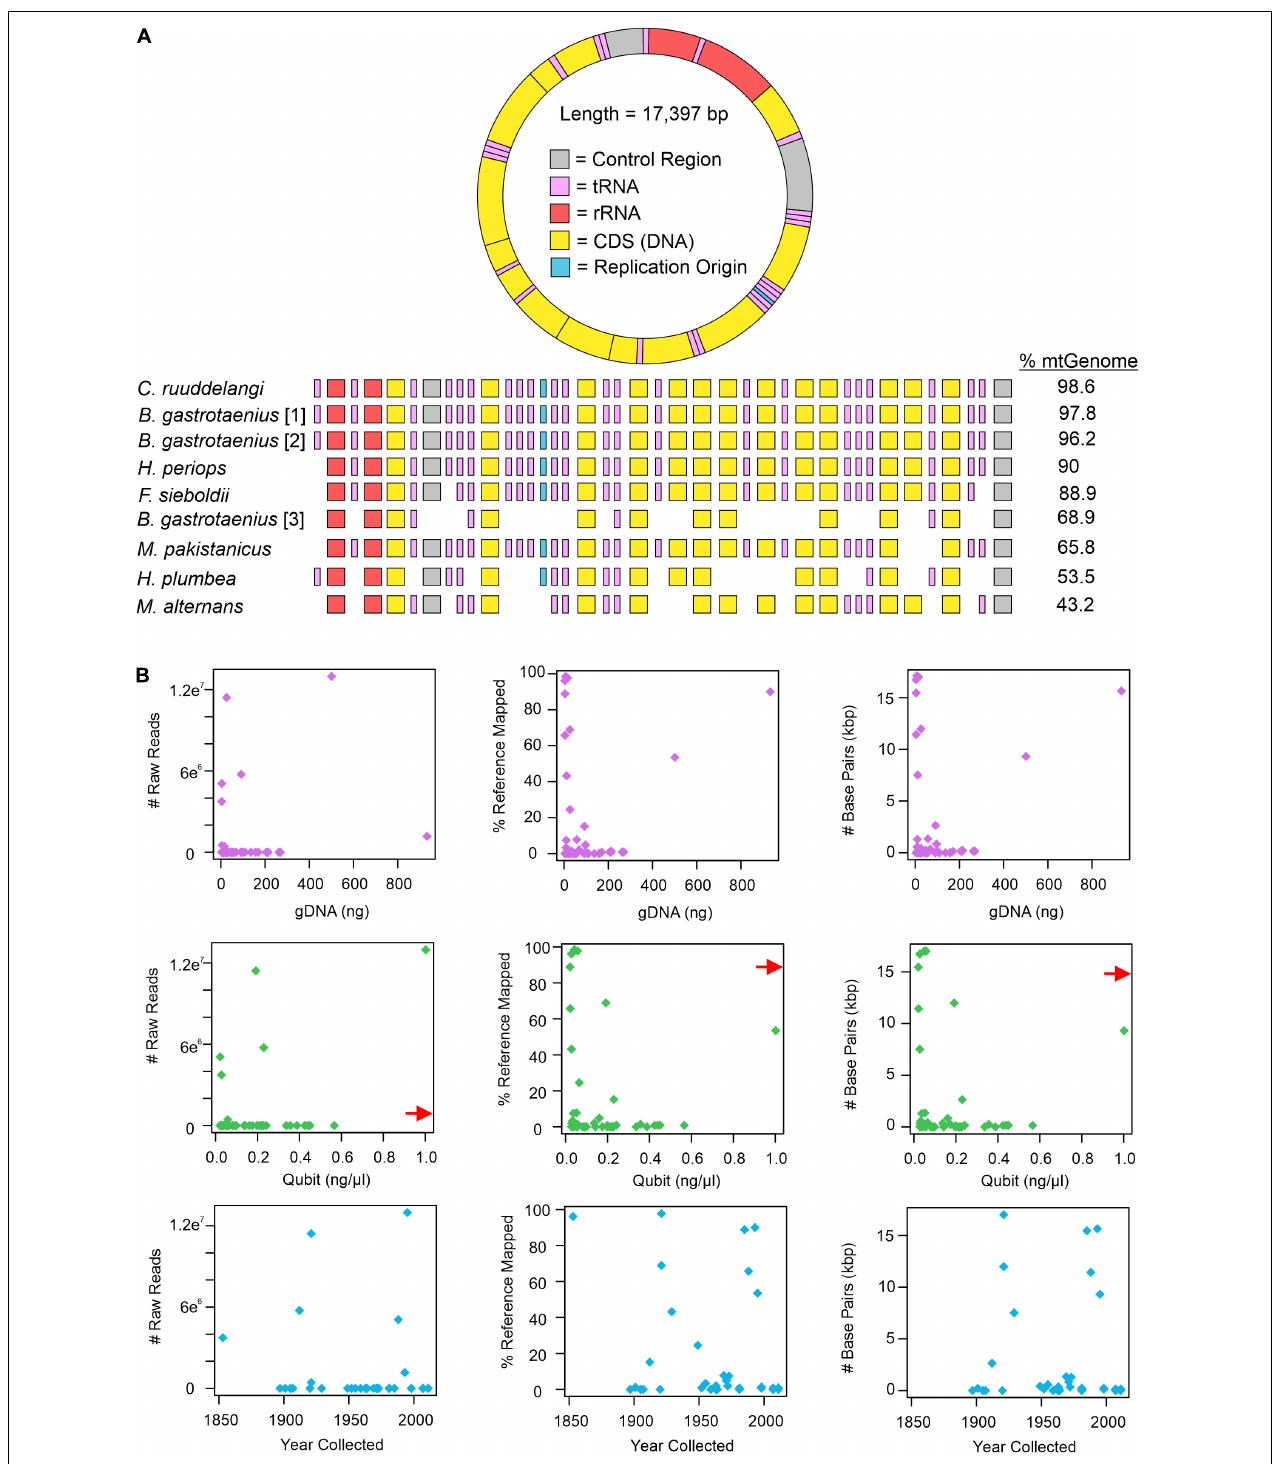
FIGURE 3 | Mitochondrial mapping results from Geneious. (A) Mapped loci from specimens genera in order include Calamophis, Brachyorrhos, Hydrablabes, Ferania, Mintonophis, Hypsiscopus, and Miralia with ≥ 25% of the whole mitochondrial reference genome (mtGenome). Blocks indicate successfully recovered regions (minimum ≥ 20% coverage). Gene regions colored in order as they appear on the reference genome. (B) Graphs showing the number of mitochondrial raw reads mapped to the mtGenome, percent of the mtGenome obtained, and the total number of base pairs obtained relative to total genomic DNA used for sequencing (gDNA; purple dots), DNA yield (Qubit score; green dots), and sample age (year collected; blue dots). Red arrow shows data point for H. periops FMNH 251051 (Qubit = ∼ 6.0 ng/ µ l), arrow positioned along axis corresponding to respective Y -axis value. The complete list of mtDNA regions and respective coverage for each specimen is in Supplementary Table 6